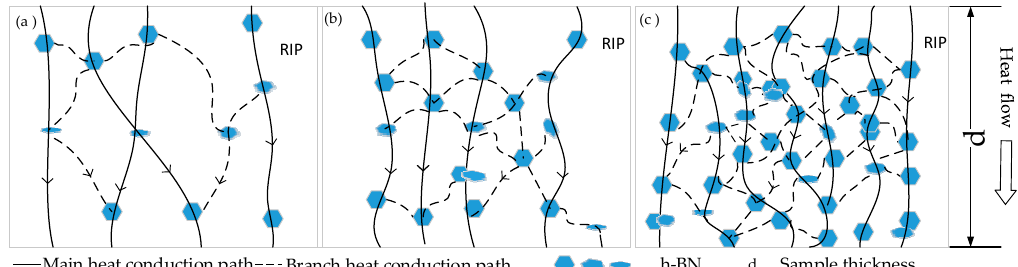
Figure 9. ( a ) h-BN modified pressboard with low filler loading (wt %); ( b ) h-BN modified pressboard with medium filler loading (wt %); ( c ) h-BN modified pressboard with high filler loading (wt %).